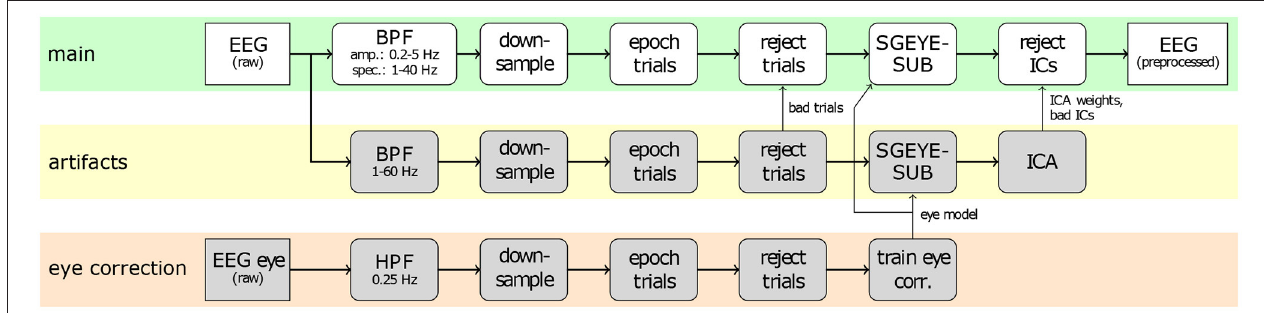
FIGURE 2 | Common preprocessing of EEG signals. The top branch (highlighted in green) shows the main preprocessing applied to the trials, whereas the lower branches show the procedures used to correct for eye artifacts (bottom, orange), and general artifacts (middle, yellow).